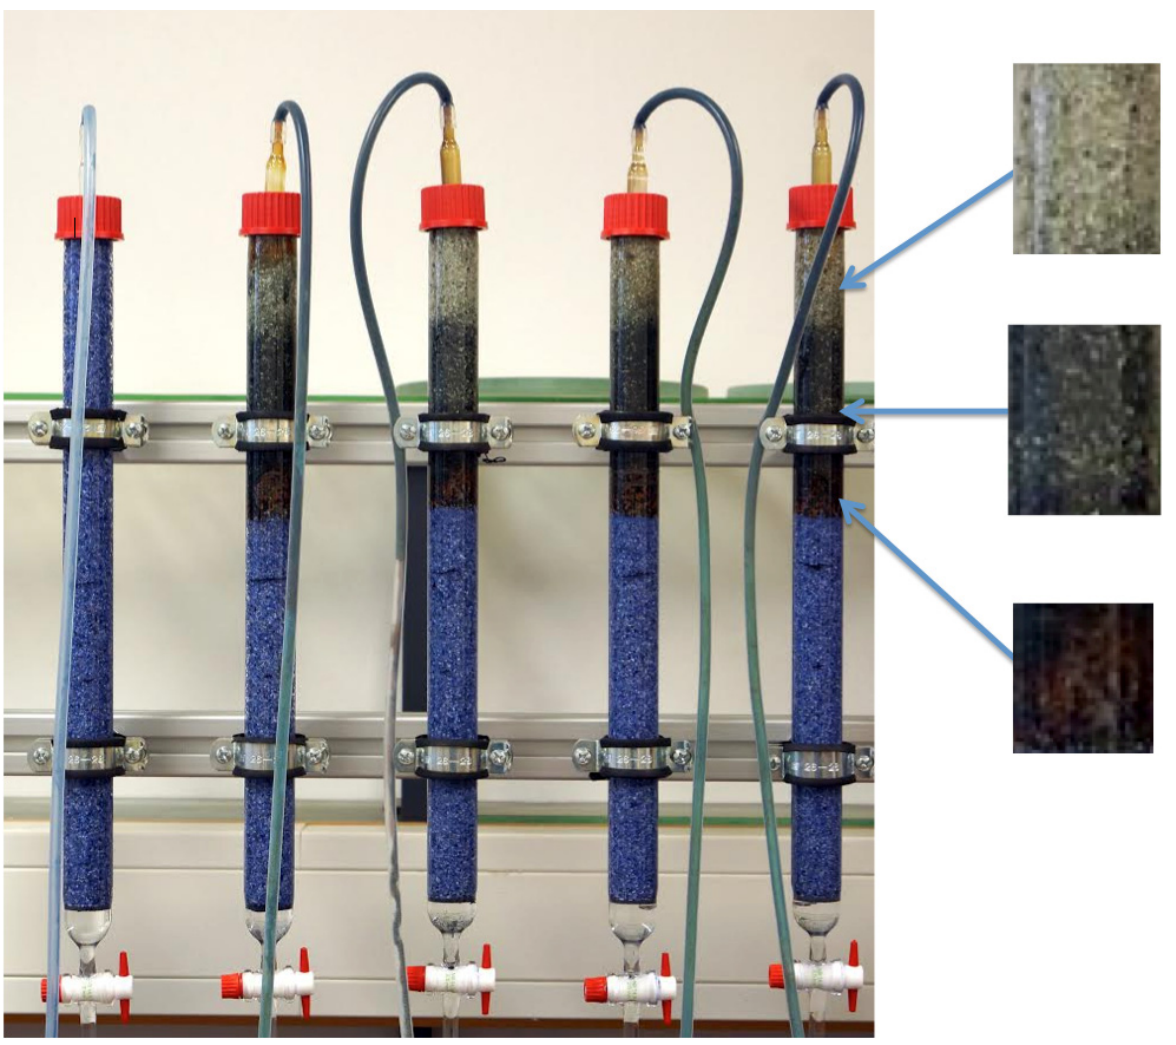
Figure 3. Photograph of a column design depicting the typical sequence of coloration described by Westerhoff and James [124]. It can be seen that the entrance zone of the Fe 0 /sand zone is colored brown while the upper section is black. The sand layer after the Fe 0 /sand zone more or less maintains its “white” color or is brownish by Fe III iron oxide from the Fe 0 /sand zone. Sand in the reference system (first column) and the sand layers preceding the Fe 0 /sand zone is blue colored by methylene blue (see